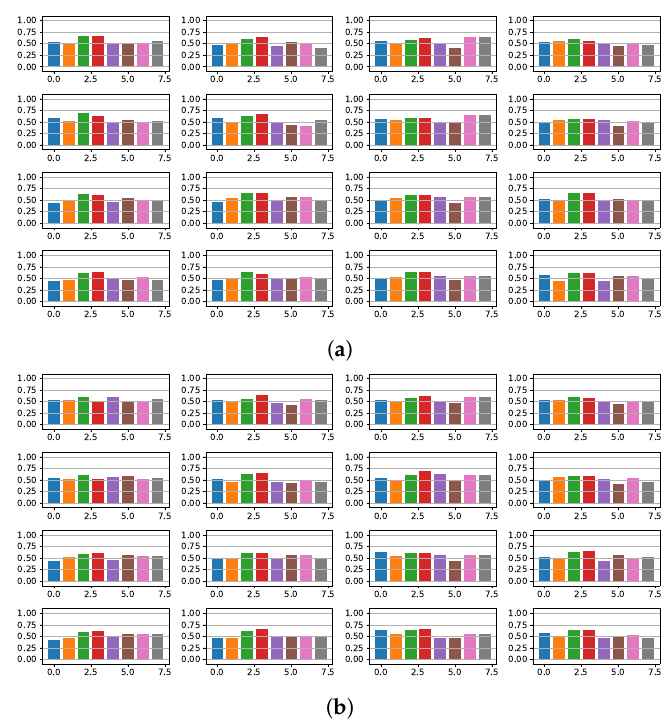
Figure 7. Accuracy of Linear SVM applied over HCM-DB. (See Figure 5 for details) ( a ) ν -SVM implementation. ( b ) C-SVM